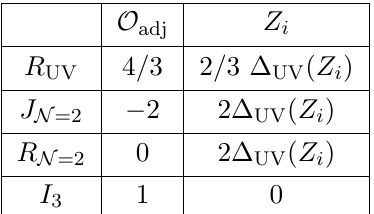
Table 1. Charge assignments for the mesons O adj and Coulomb branch parameters Z i in the UV